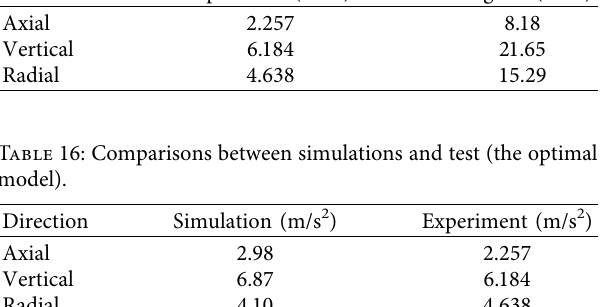
Table 15: Comparison of the experimental results. Direction